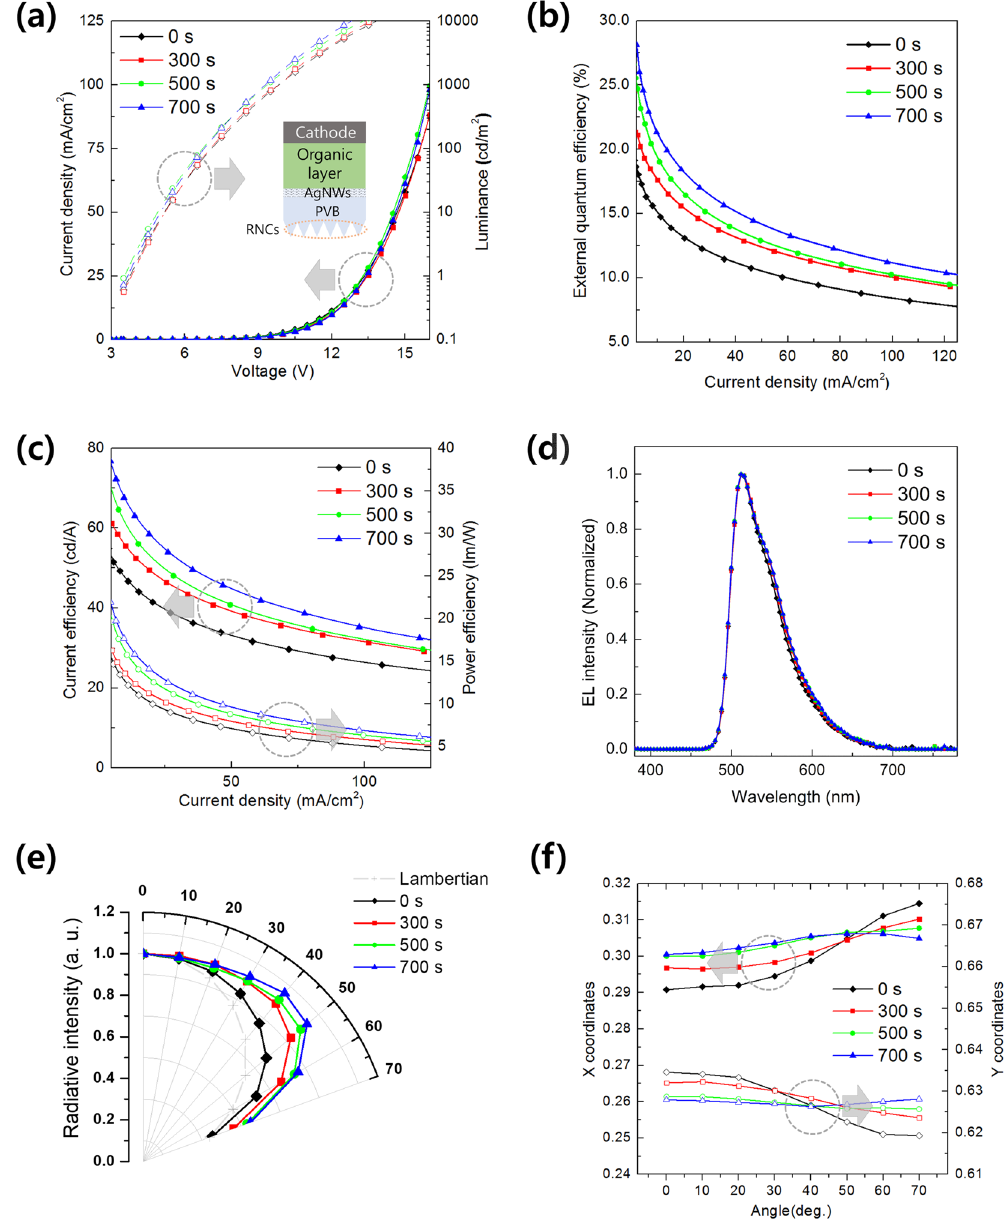
Figure 5. Performance characteristics of phosphorescent green flexible OLEDs: ( a ) current density (J)-voltage (V)-luminance (L) characteristics of OLEDs as a function of etching time, ( b ) EQE as a function of current density, ( c ) CE and PE as a function of current density, ( d ) normalized EL spectra at 1.2 mA/cm 2 , ( e ) normalized angle dependence of electroluminescence intensity (Lambertian emission pattern is displayed as dashed line), and ( f ) CIE X- and Y- coordinates of green OLEDs measured at viewing angles from 0° (substrate normal) to